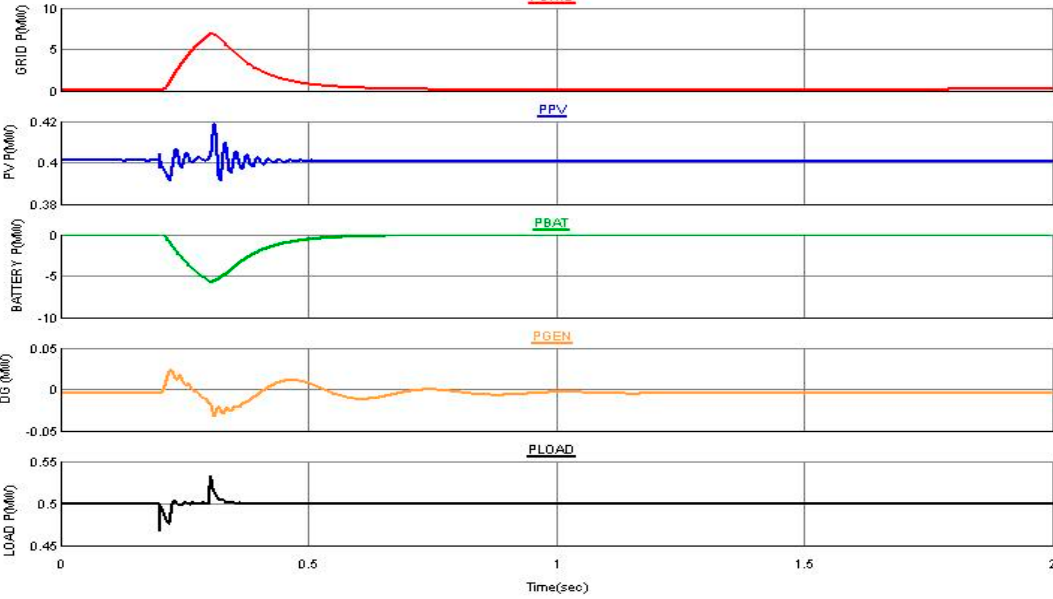
Figure 9. Grid power P GRID , PV array output power P PV , battery power P BAT , generator power P GEN and load power P LOAD .